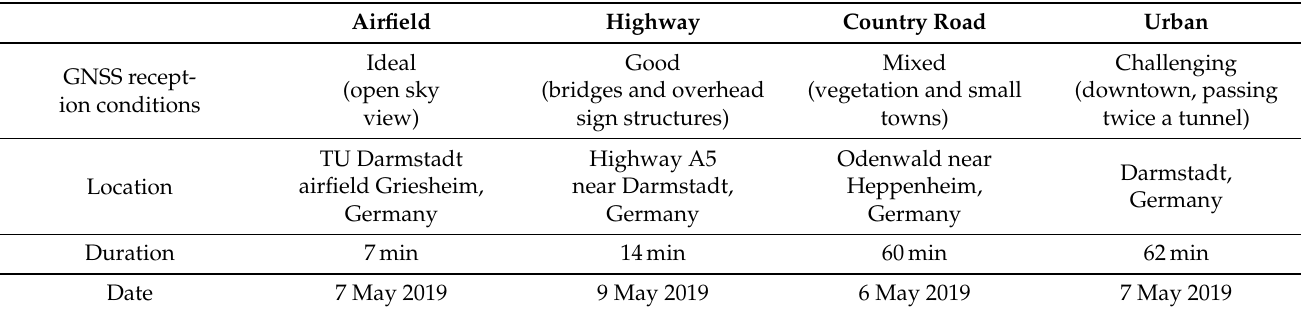
Table 6. Characteristics of the four selected scenarios to compare the implemented integrity